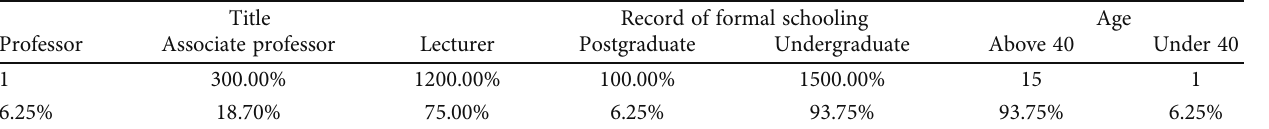
Table 5: Statistics of